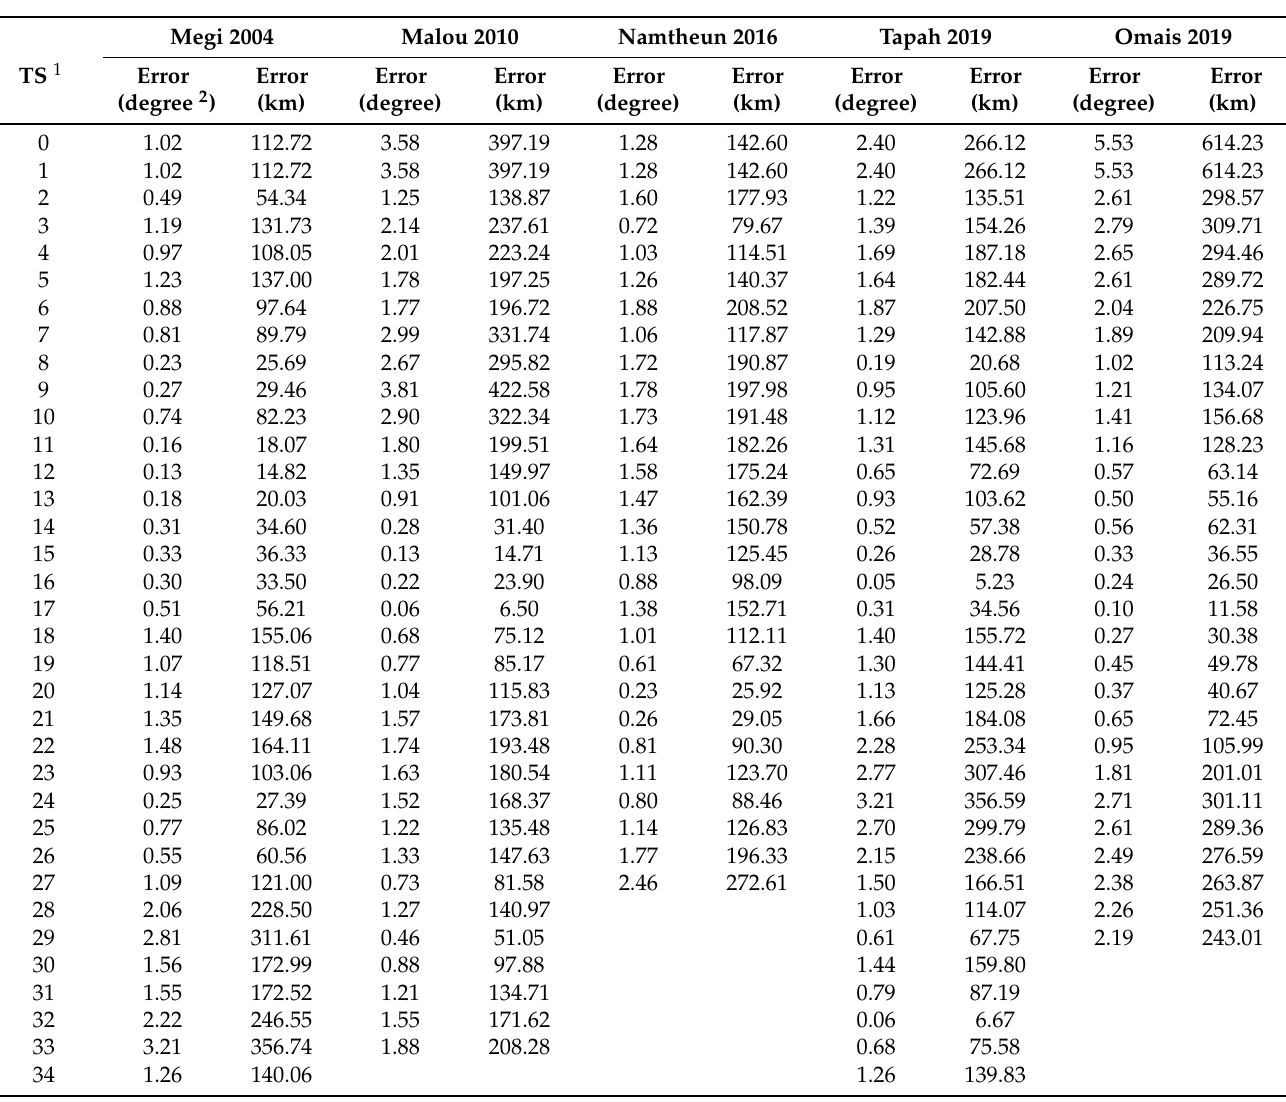
Table A1. Errors in degree and distance in kilometers of actual and predicted paths from five